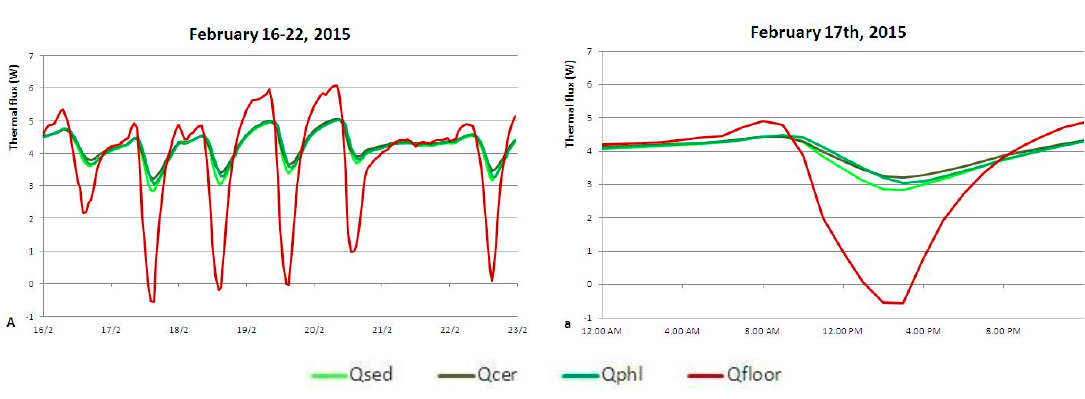
Figure 13. Analysis of winter heat flows: ( A ) sample week; ( a ) sample day.